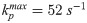
Final steady state configuration of the membrane is reached faster in the case of non-progressive gel for different values of edge tension.The dynamics of membrane’s middle point versus time for different values of edge tension Fe = [4, 8, 12, 16, 20] pN, with filaments polymerization rate equal to kpmax=52s-1. (a) Non-progressive versus (b) progressive gel boundary with vgmax=30nm/s.